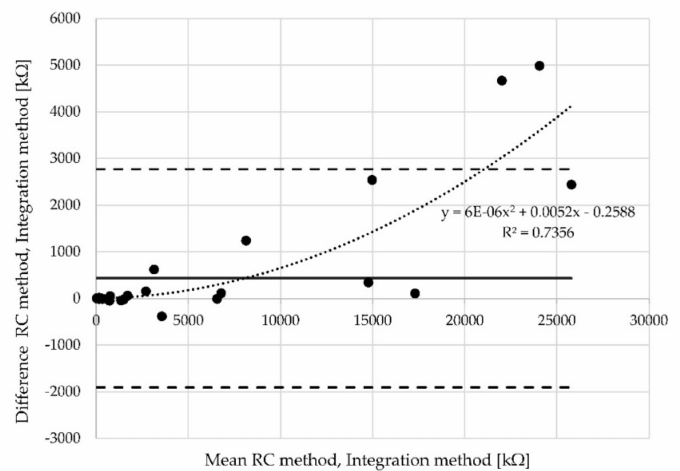
Figure 14. Bland-Altman plot for all samples measured at probe “A”.